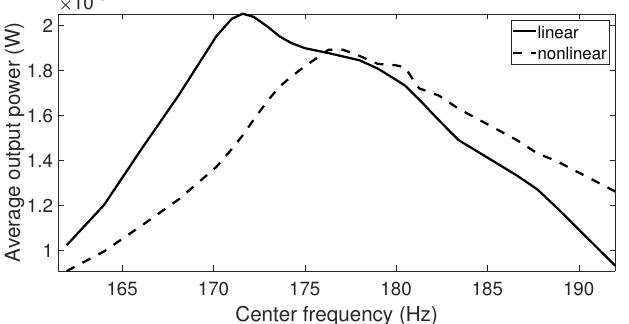
Figure 14. The average output power response for the linear and nonlinear prototypes under bike excitation when the center frequency of the excitation is